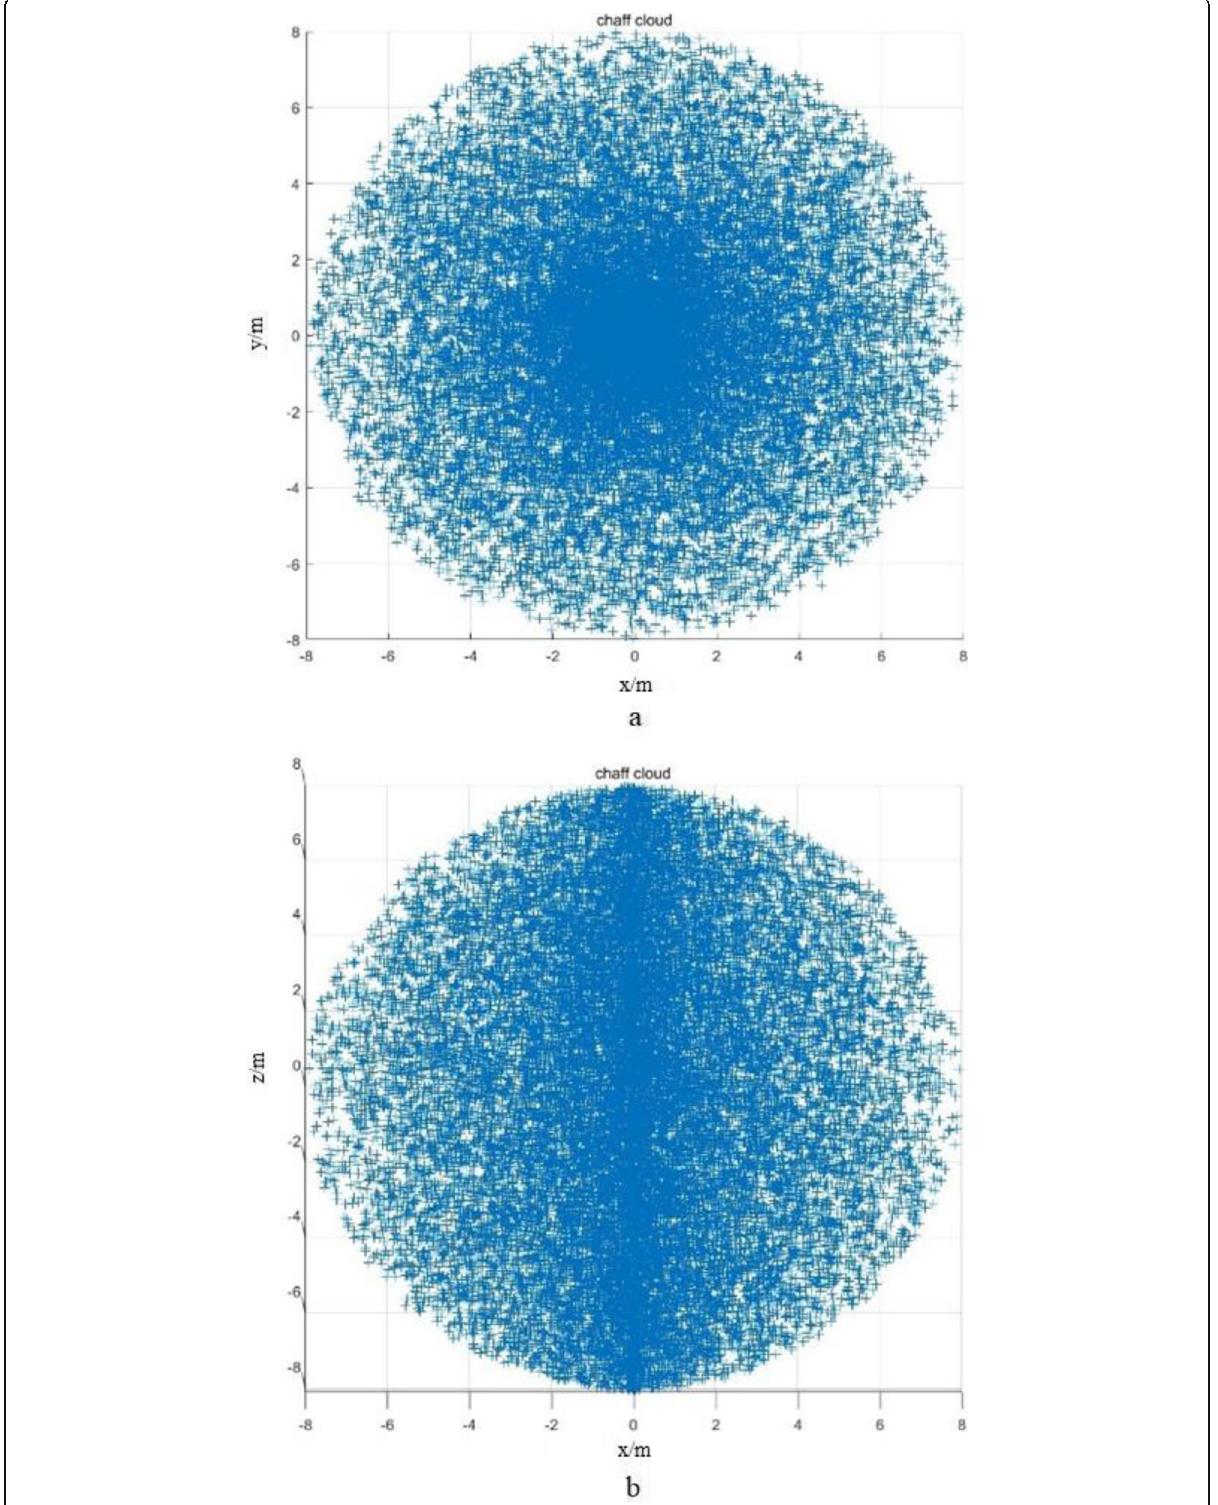
Fig. 4 The x – y and x – z cross sections of the chaff cloud: a the x-y cross section, b the x-z cross